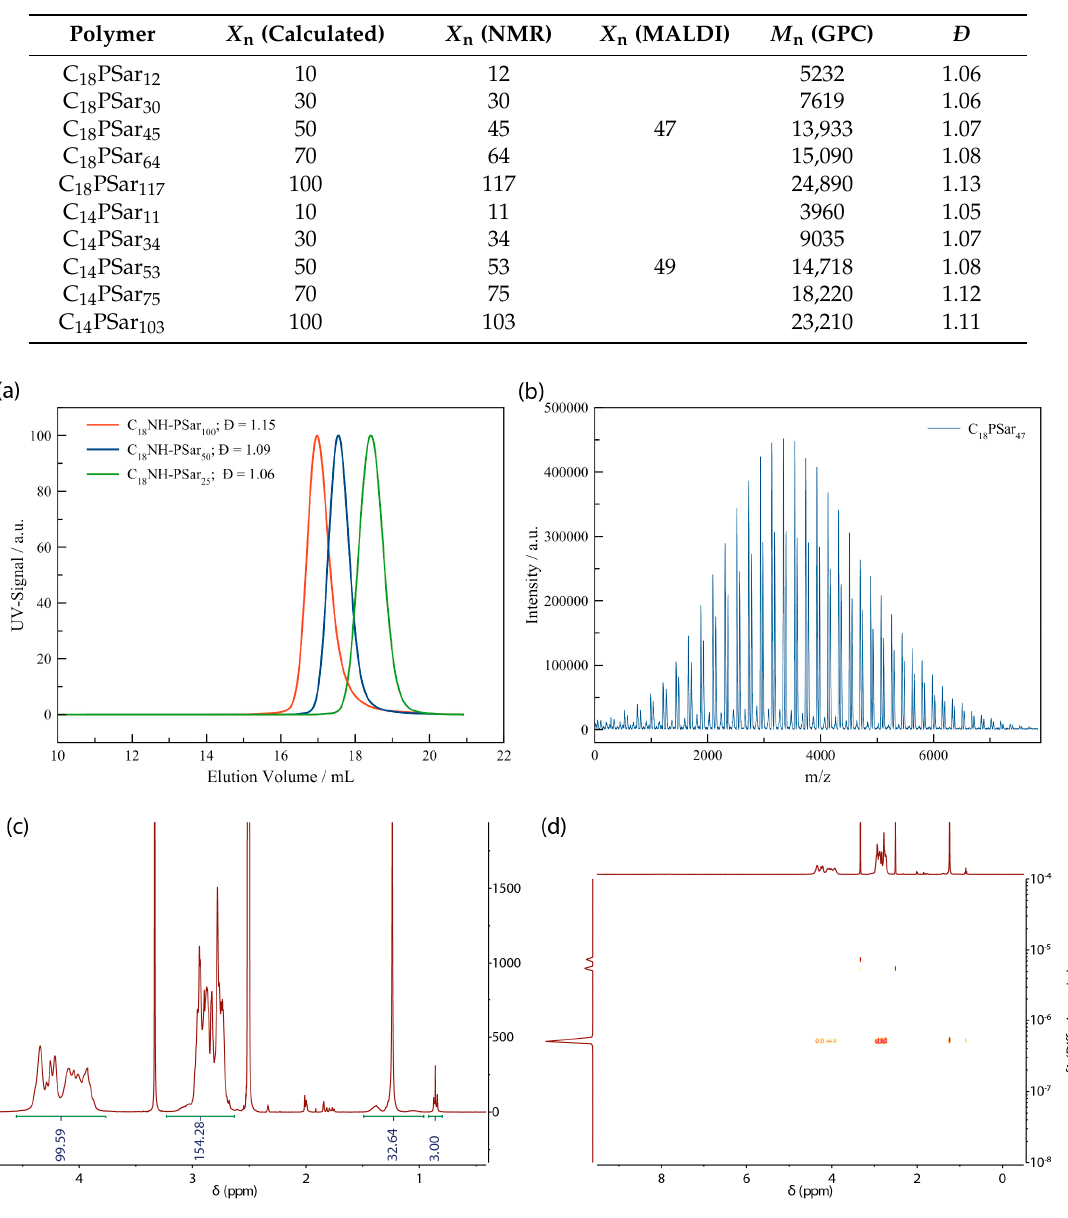
Figure 1. Exemplary polymer analysis of lipopolypeptoids ( a ) HFIP SEC of C 18 PSar 34 , C 18 PSar 45 , and C 18 PSar 117 ; ( b ) MALDI TOF MS of C 18 PSar 47 ; ( c ) 1 H NMR of C 18 PSar 47 ; and ( d ) 1 H DOSY NMR of C 18 PSar 47 .